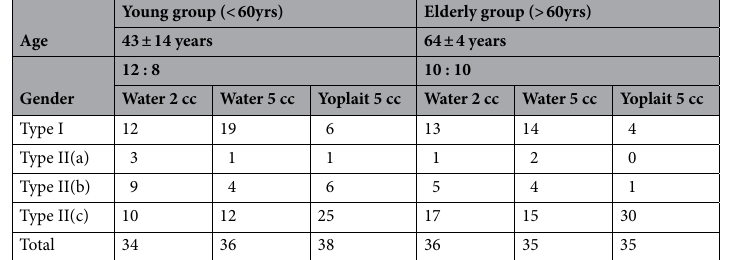
Table 2. The classification and frequency of the muscle activation patterns observed in oropharyngeal muscles during swallowing test.